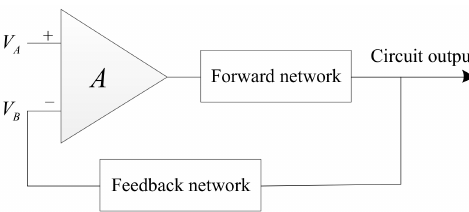
Figure 3. The schematic of the analog circuit.